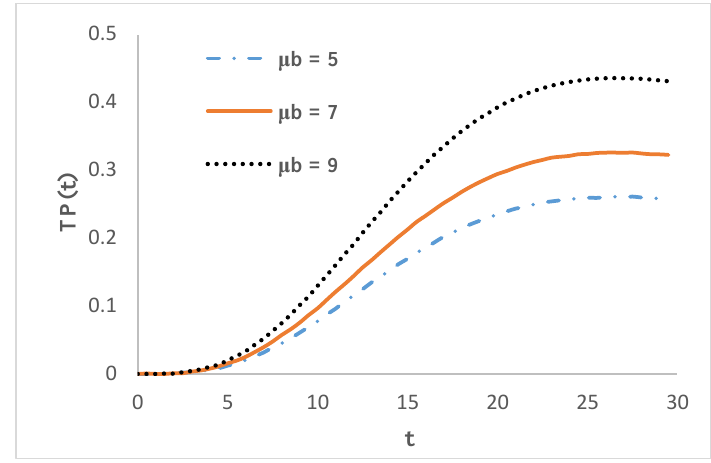
Figure 8. Effect of